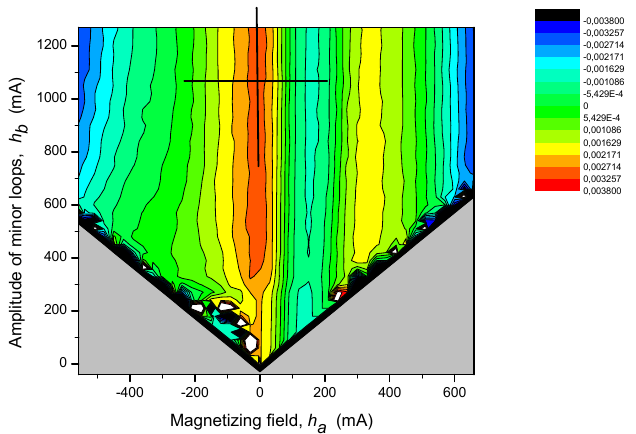
Figure A3. Relative sensitivity map of the µ -degradation functions, µ (DBTT) ≡ µ (h a , h b ) . Crossing the lines indicates the h a = − 30 mA and h b = 1080 mA field coordinates of the µ i (DBTT) -degradation function presented in Figure 3.